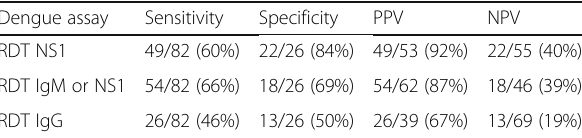
Table 3 Dengue RDT sensitivity and specificity on 109 clinical samples Dengue